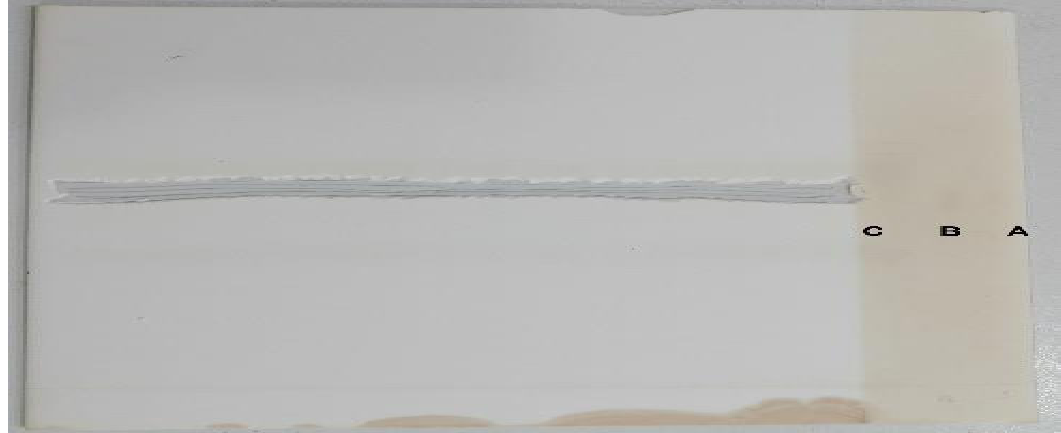
Figure 8 . Preparative TLC for hexane fraction, A: Beta-sitosterol (standard), B: Stigma-sterol, C: Hexane fration, mobile phase: Hexane: ethyl acetate (10: 4). A- preparative TLC test was performed on ethyl analysis using mobile phase: chloroform: methanol: acetate fraction to isolate the rutin for farther formic acid (15: 4: 1) as shown in (Figure 9).